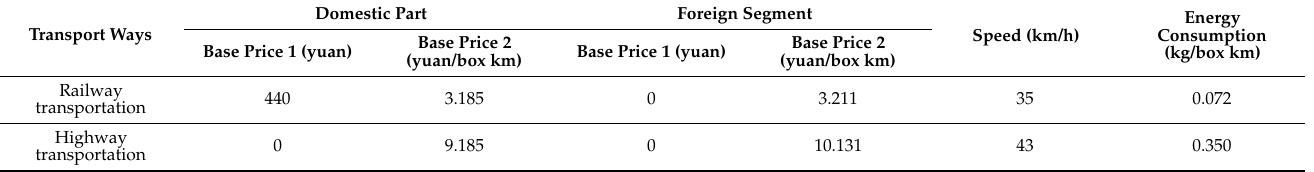
Table 4. The freight rate, speed and energy consumption of each mode of transportation